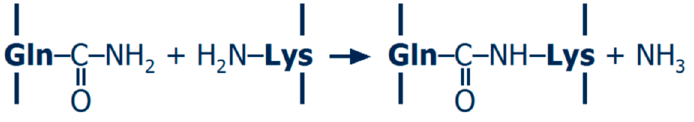
Figure 2. Reaction scheme of protein polymerisation by transglutaminase.